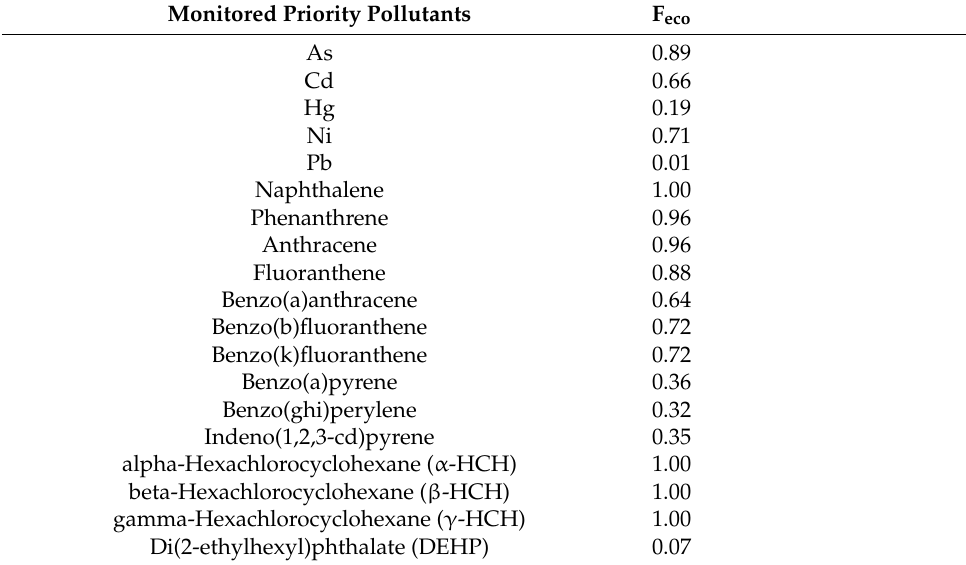
Table 3. Exposure factor (F eco ) values , according to USEtox [46,47]. Monitored Priority